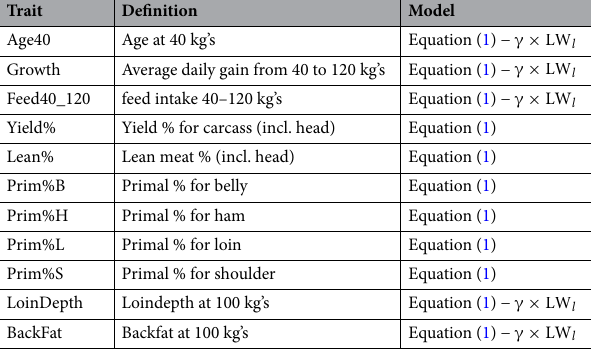
Table 1. Trait definitions and models for estimation of genetic